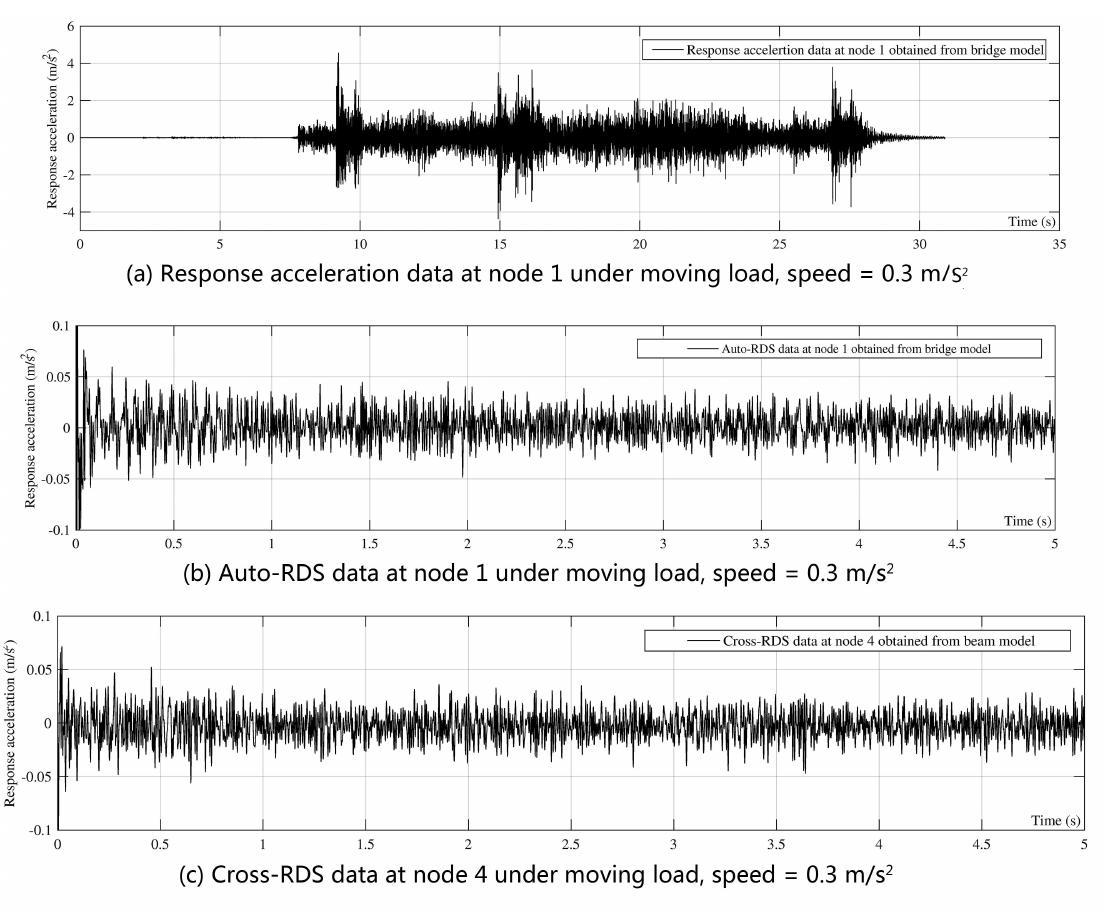
Figure 11. ( a ) Response acceleration data recorded at node 1, ( b ) auto-RDS of node 1, and ( c ) cross-RDS of node